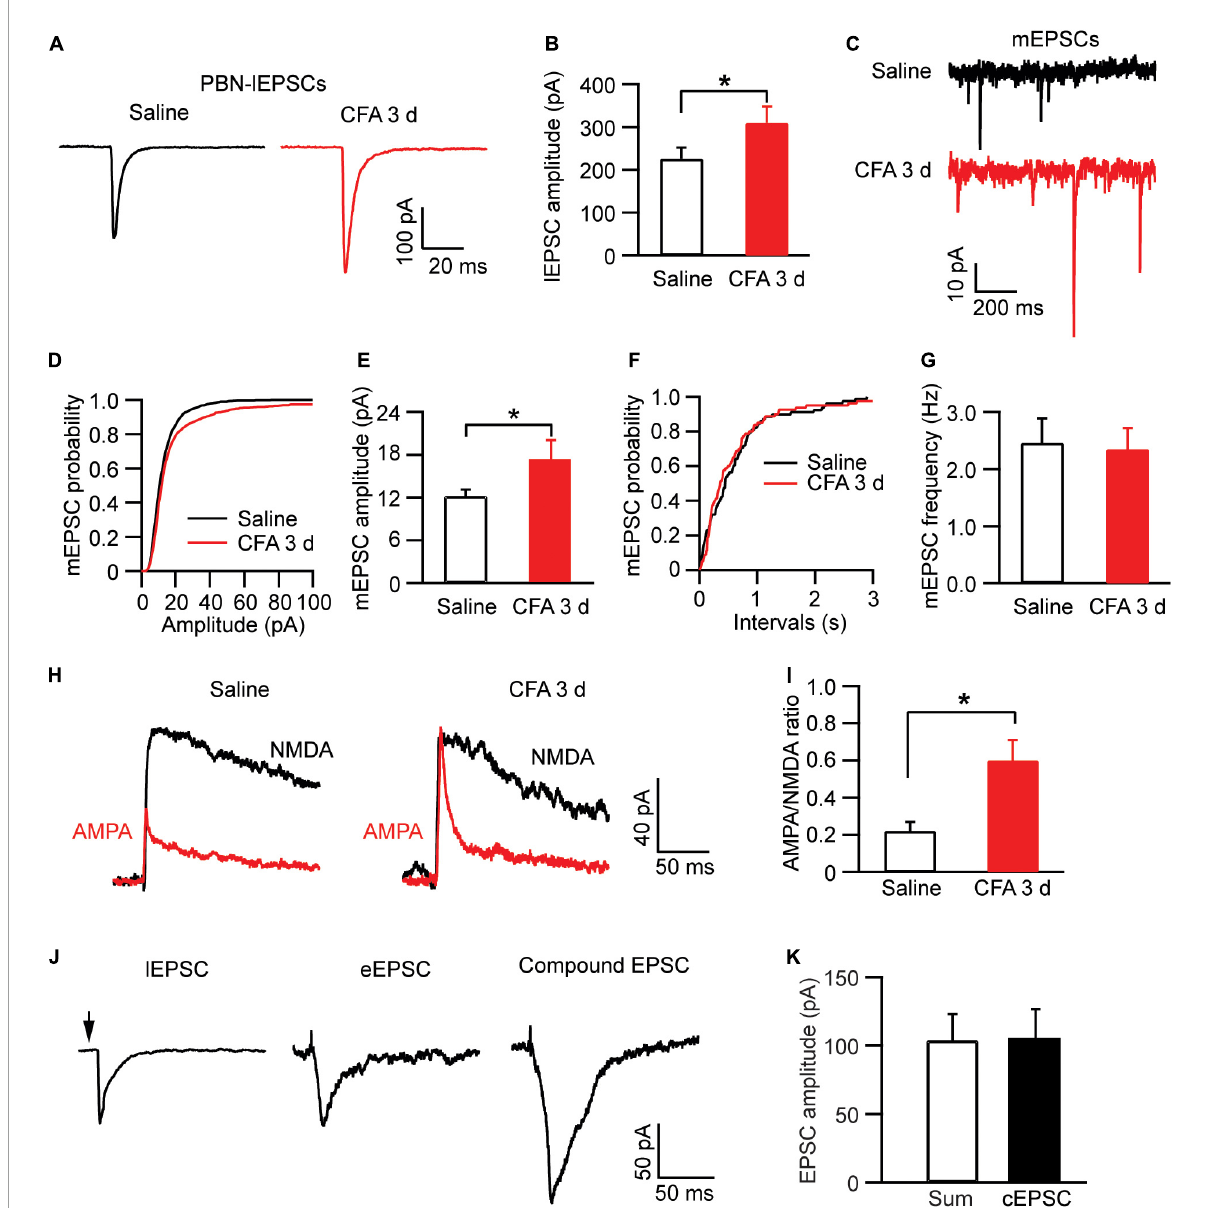
FIGURE7 Persistent pain activates PBN–CeAl inputs in PBN-input-only CeAl cells. (A,B) PBN-elicited lEPSC traces (A) and group data of lEPSC amplitude (B) in the PBN-input-only cells in CeAl from the saline and CFA rat groups. (C–G) mEPSC traces (C) and group data of mEPSC amplitude (D,E) and mEPSC frequency (F,G) in the PBN-input-only cells in CeAl from the saline and CFA rat groups. (H,I) Representative current traces of AMPA EPSCs and NMDA EPSCs (H) , and group data of AMPA/NMDA ratio in the saline and CFA groups. (J) Representative current traces of a lEPSC and an eEPSC, and a compound EPSC (cEPSC) evoked by simultaneous light and electrical stimulation in the same dual-input cell. (K) Group data of amplitudes of the sum of the lEPSC and eEPSC, and cEPSC in each dual-input cell. * p <